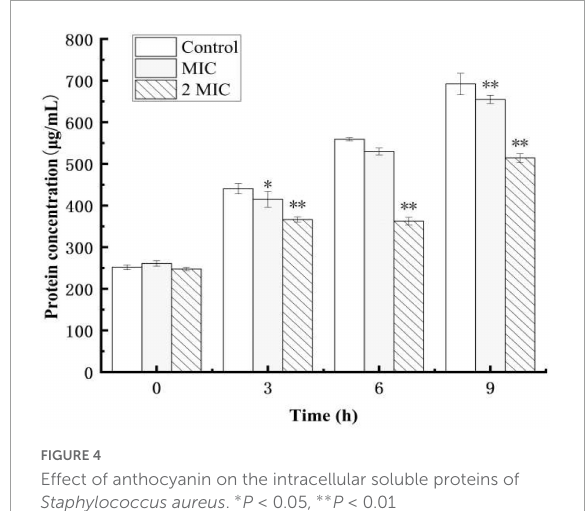
FIGURE2 Effect of anthocyanin on the surface hydrophobicity of Staphylococcus aureus cells control. ∗∗ P < 0.01.